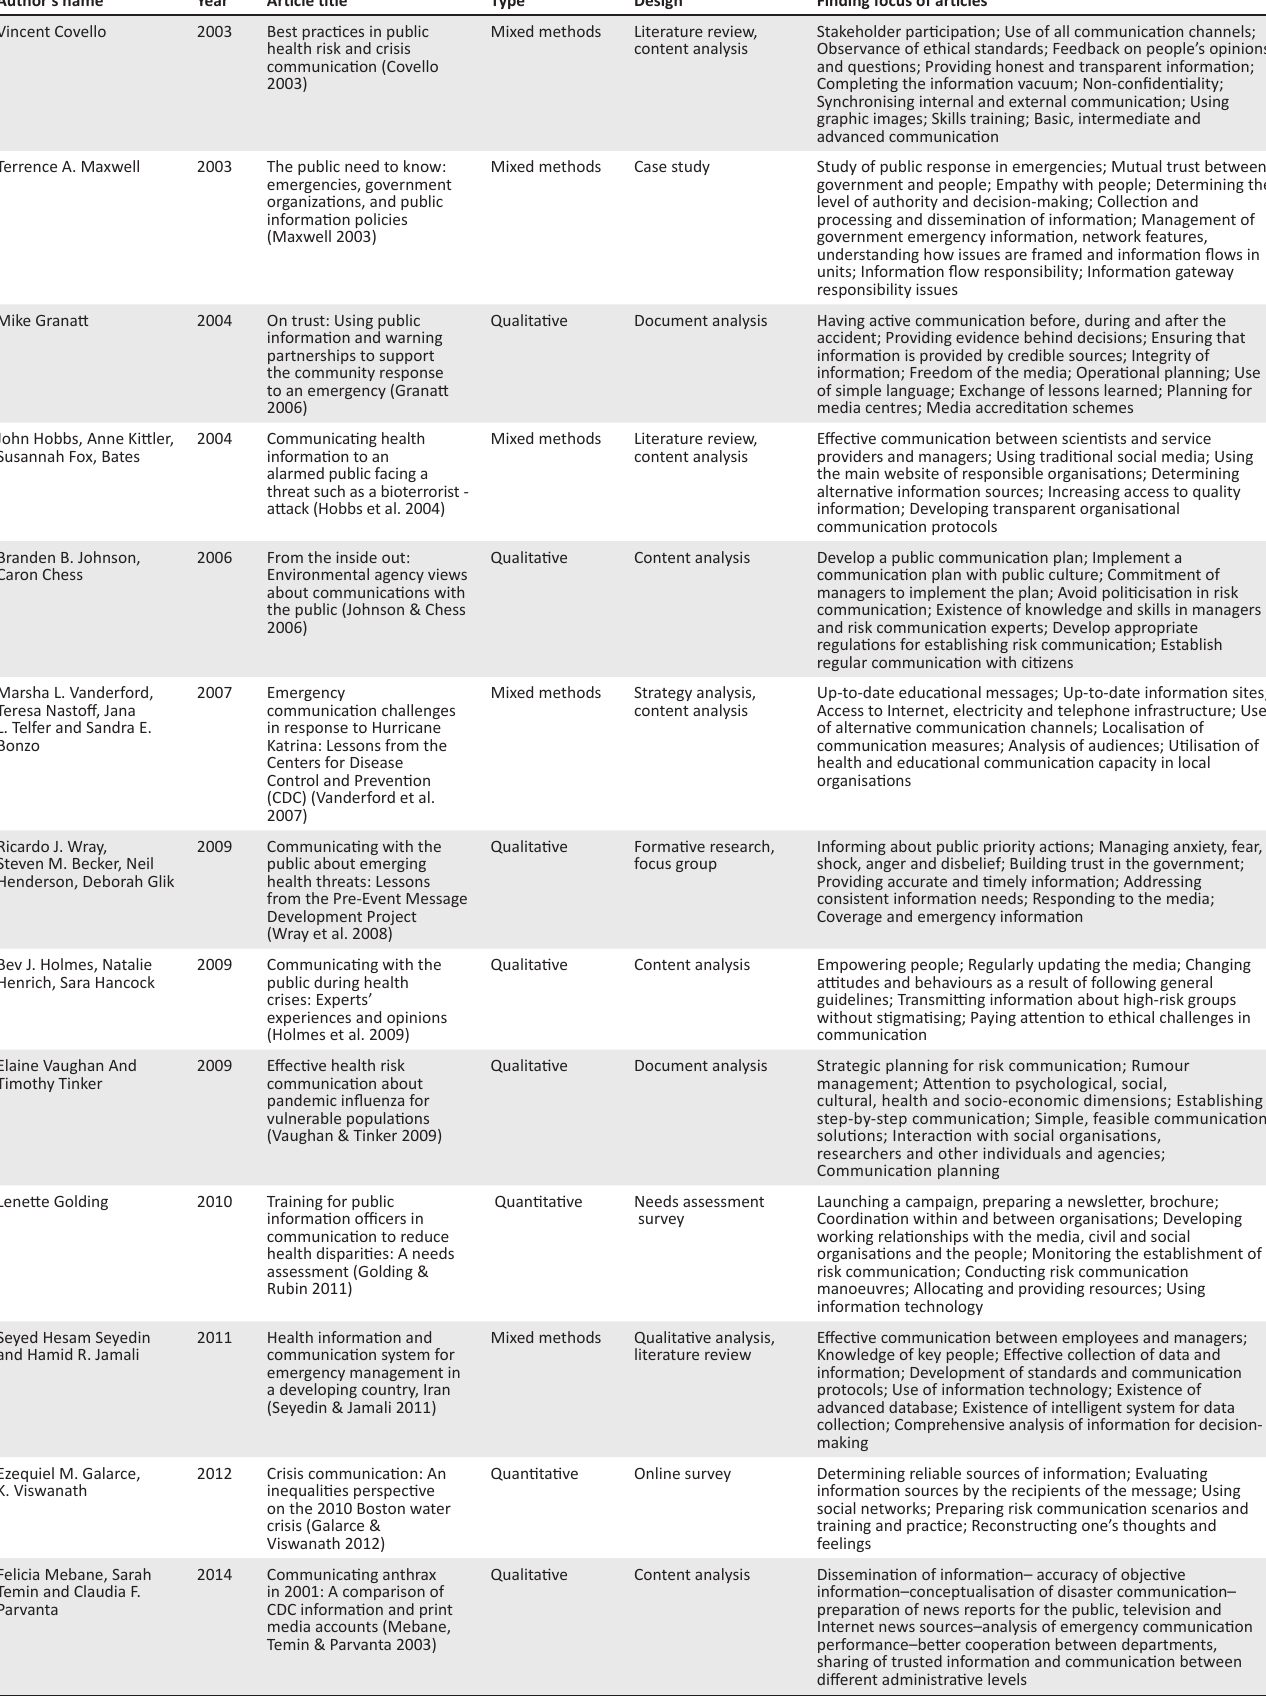
TABLE 3: Characteristics of the articles included in the systematic